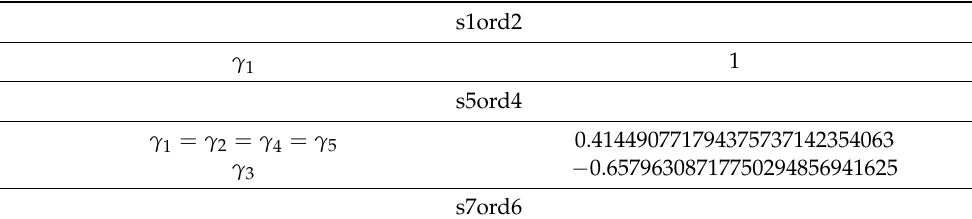
Table 1. Coefficients for composition schemes of different orders of accuracy